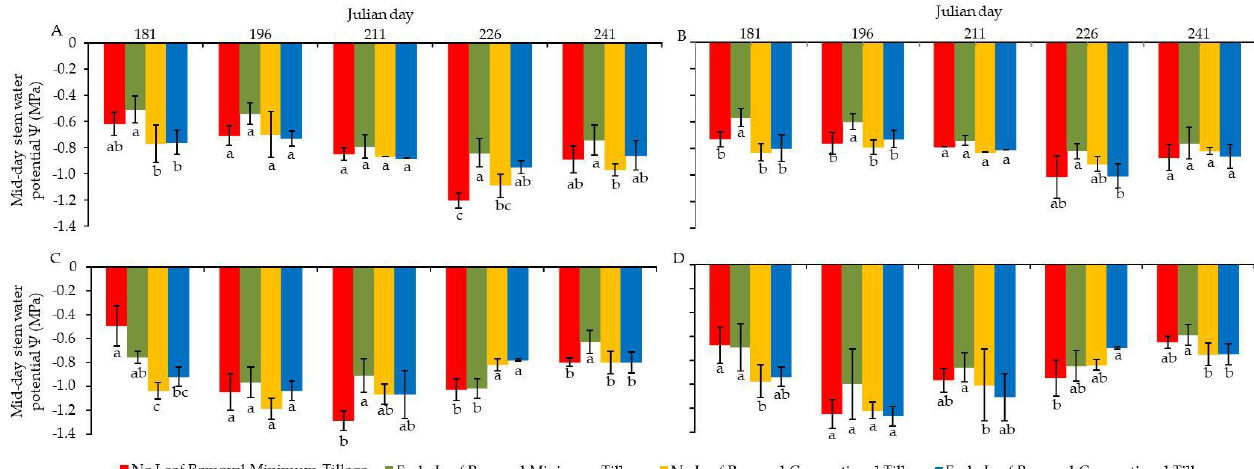
Figure 2. Mid-day stem water potential measured in 2017 (( A ) primary leaves, ( B ) lateral leaves) and 2018 (( C ) primary leaves, ( D ) lateral leaves) for the four combinations analyzed. For each year, treatment and day of the year, the values marked by different letters are significantly different ( p ≤ 0.05) based on Tukey’s HSD test (bars indicate ± standard deviations).